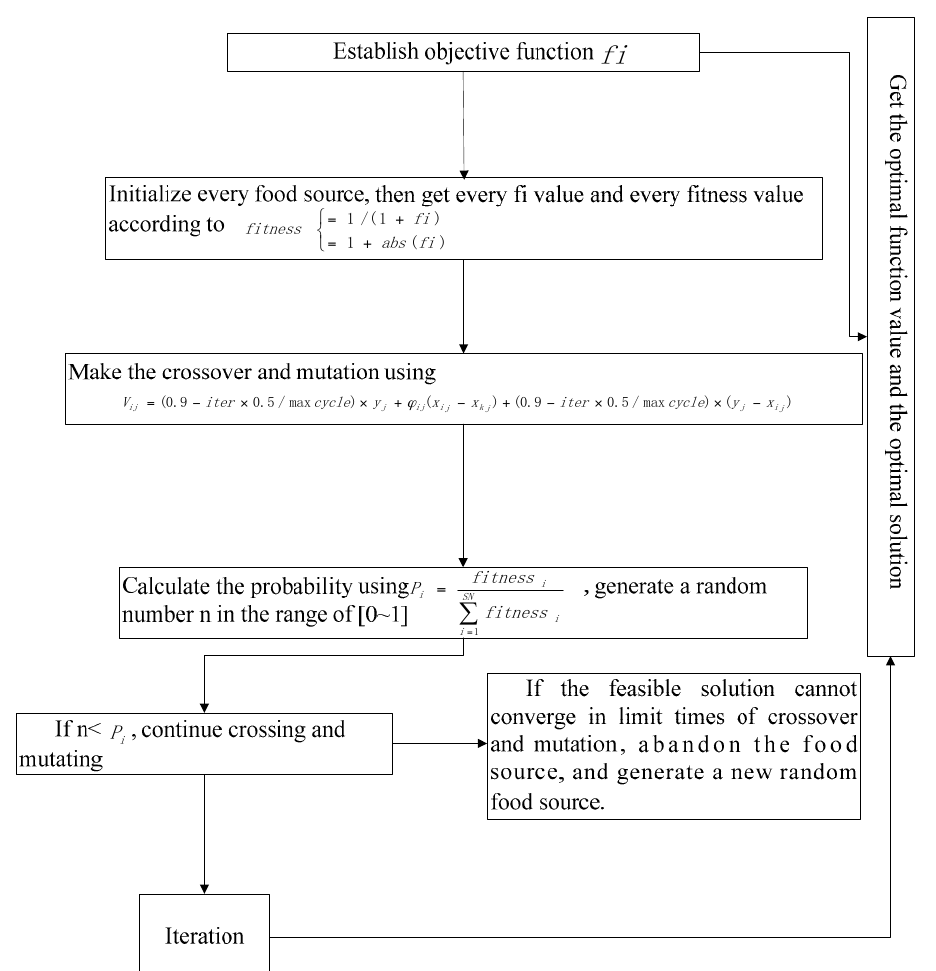
Figure 1. The flowchart of the WGABC algorithm.